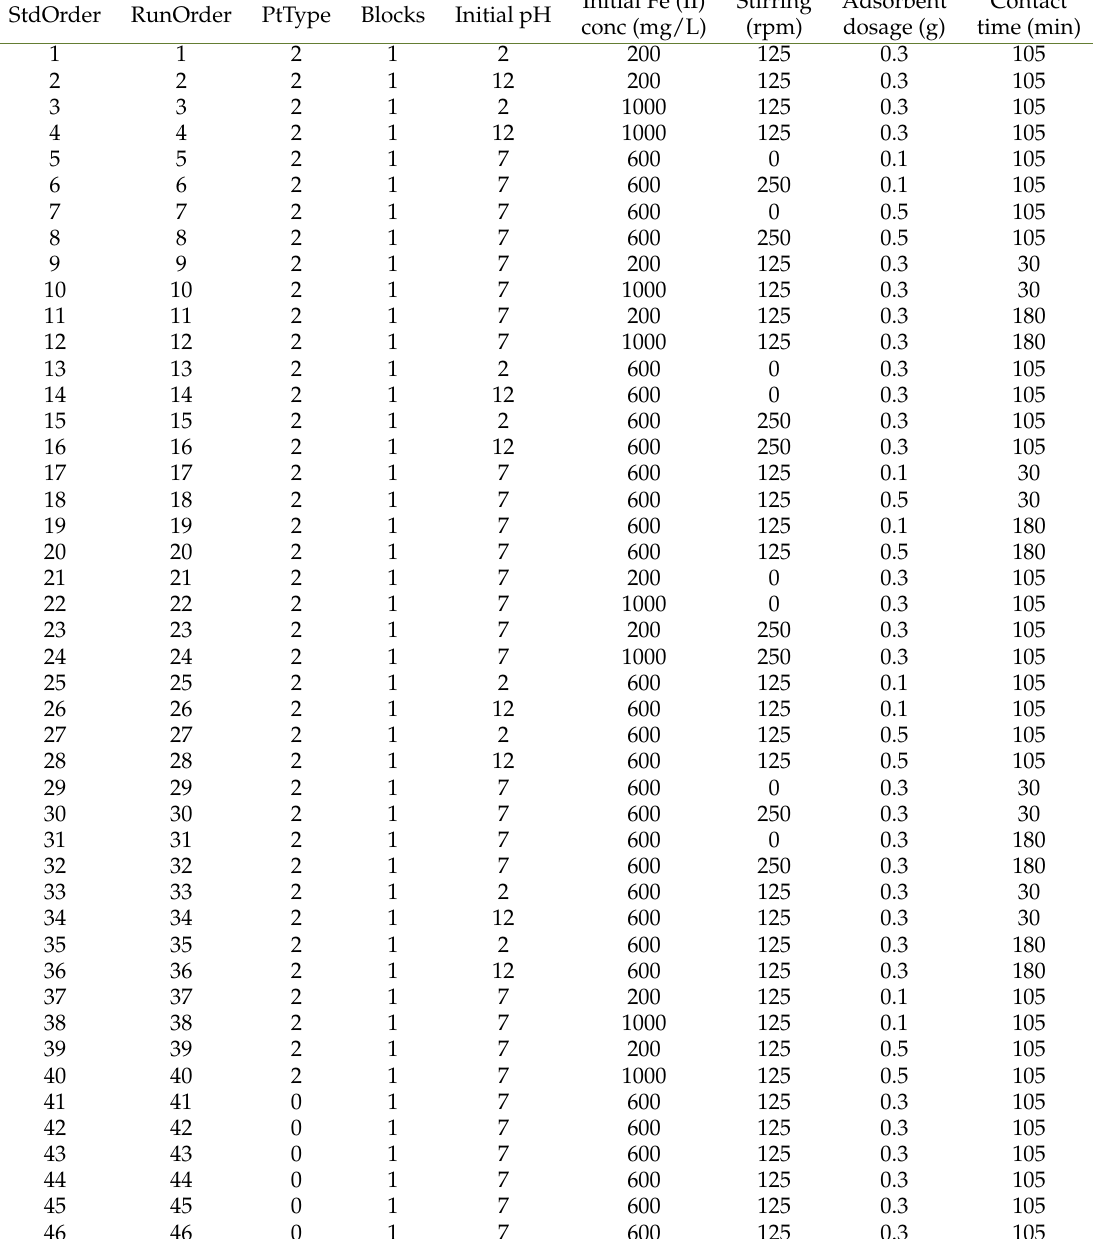
Table 6. Appendix: Experimental design